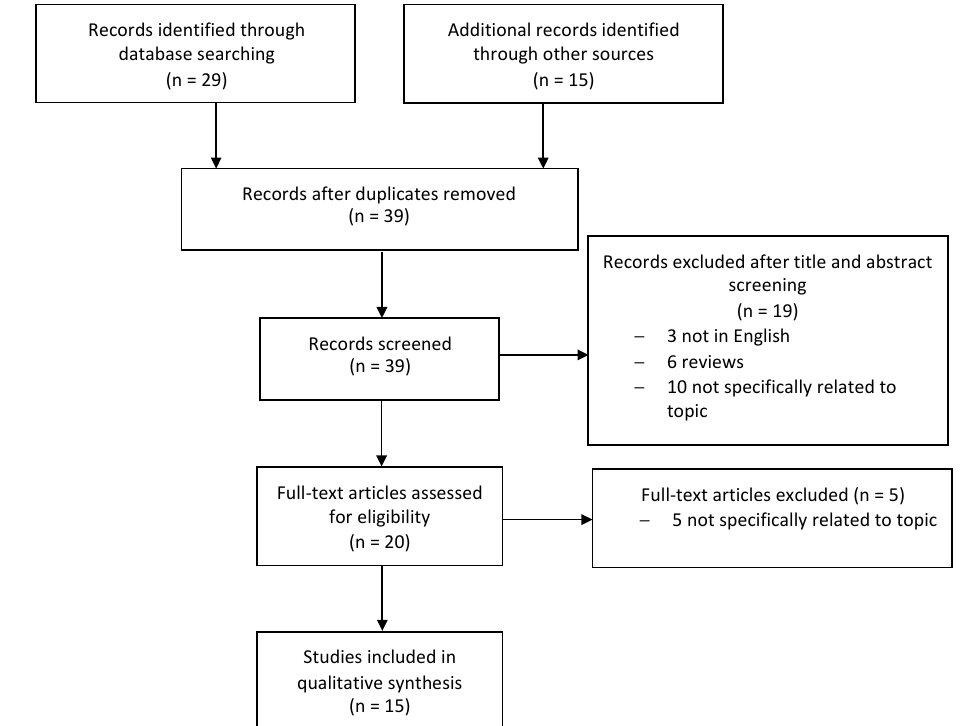
Figure 3. Study flow diagram: PRISMA flow diagram of identification, screening and inclusion of articles. Systematic literature reviews, were selected with standard methods to be briefly presented in the article. The search identified 15 studies with the desired characteristics.